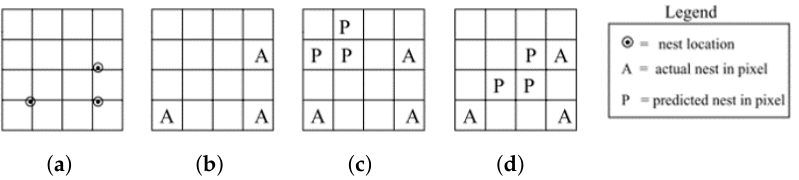
Figure 11. Reprinted with permission from [180] (Copyright ©2001 Society for Industrial and Applied Mathematics. All rights reserved.) Spatial accuracy. ( a ) Actual location of nests, ( b ) Rasterized location of nests, ( c ) Predicted locations 1, ( d ) Predicted locations